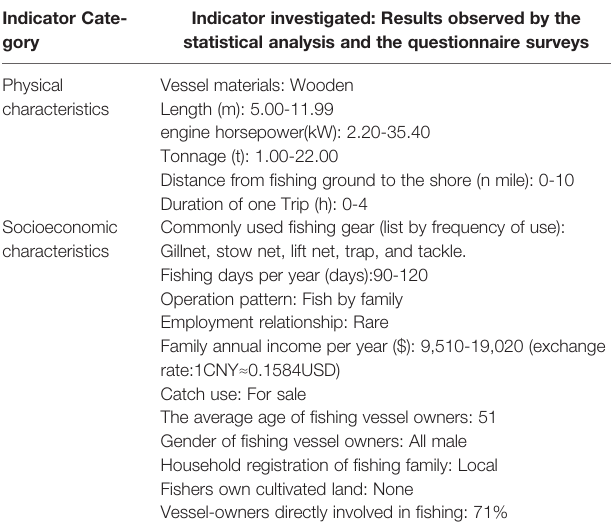
TABLE 2 | A summary of the general characteristics of SSFs in Shengsi. Indicator Cate- Indicator investigated: Results observed by the gory statistical analysis and the questionnaire surveys Physical characteristics